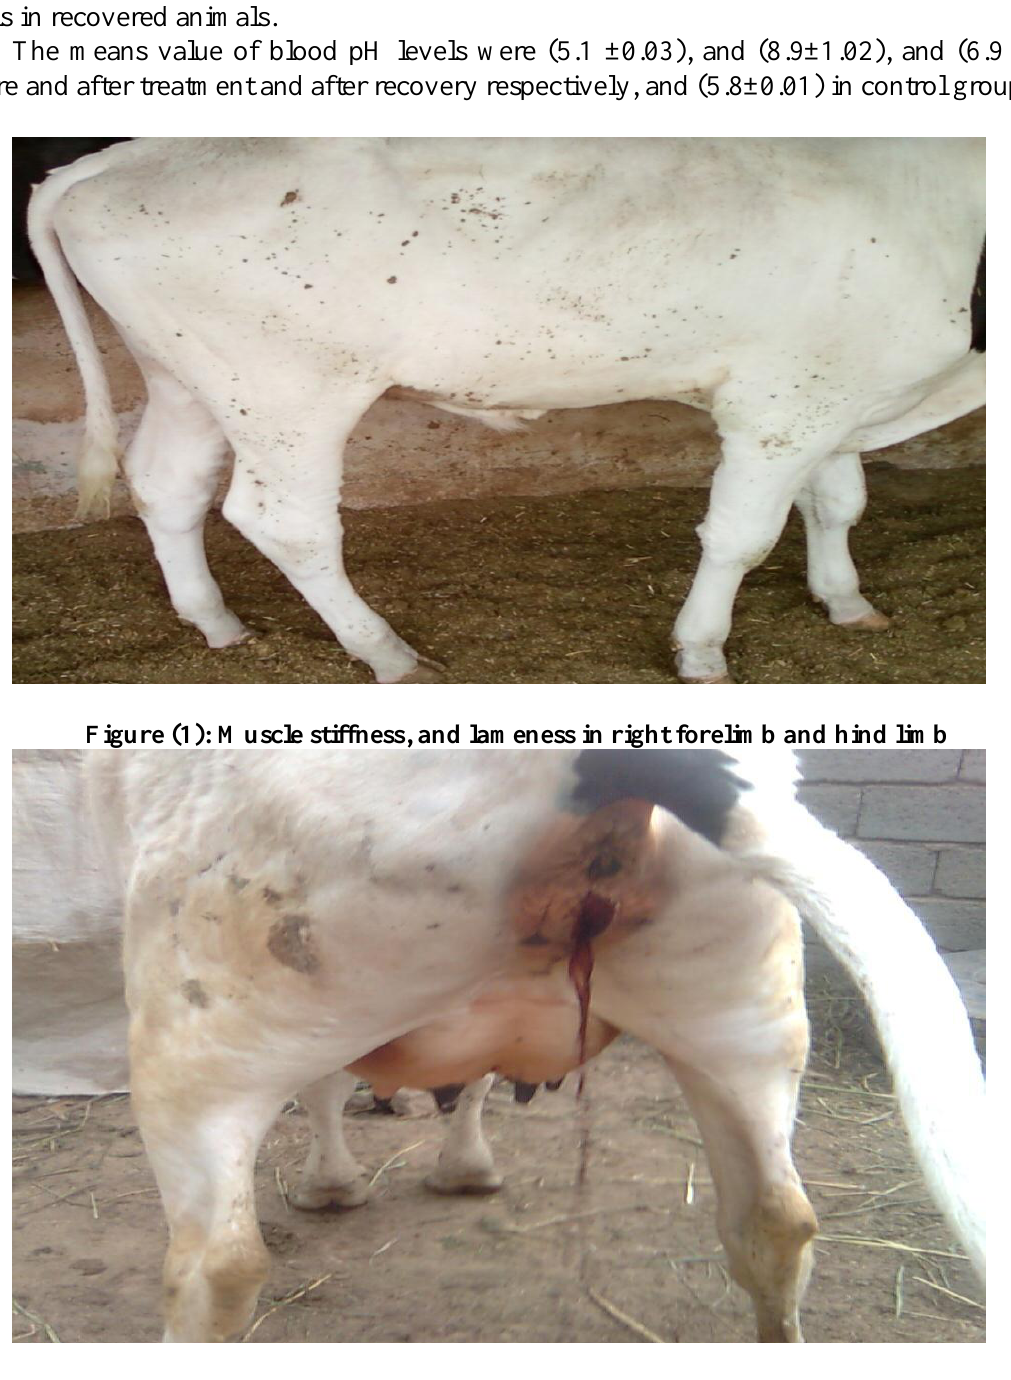
Figure (2): red water urination in infected